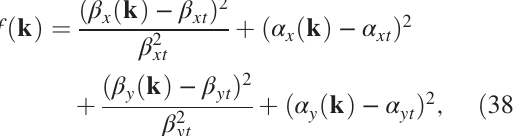
FIG. 3. Derivatives of final horizontal and vertical emittance with respect to eight beam parameters.